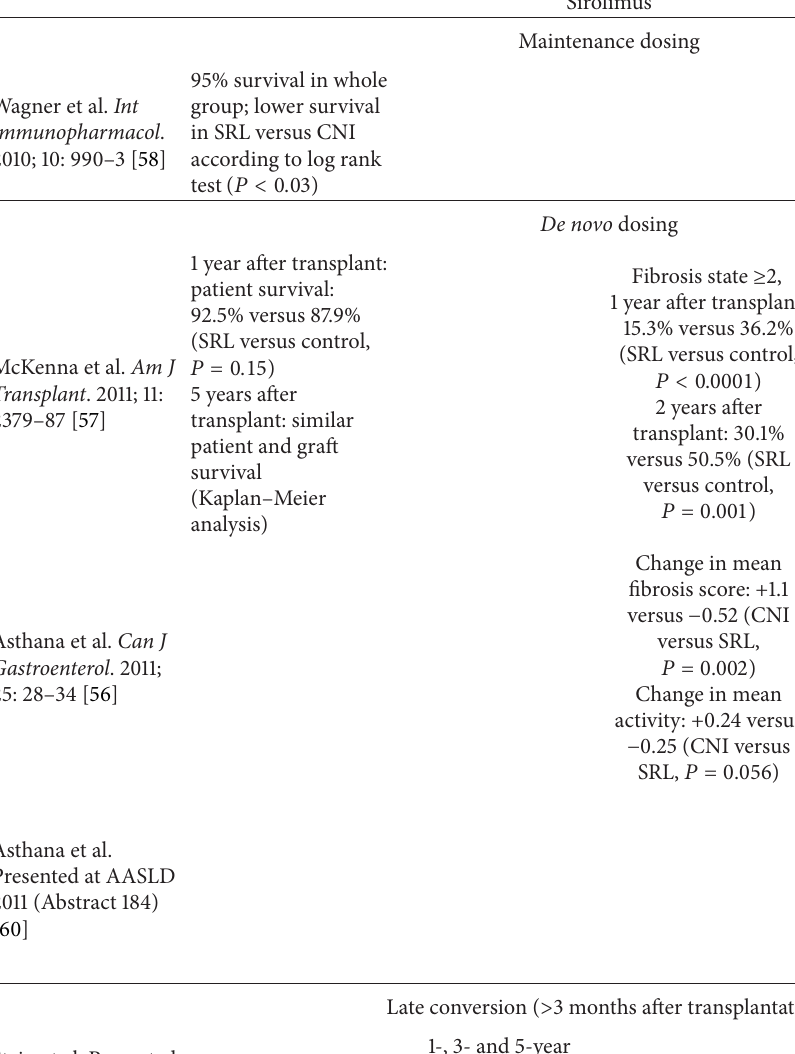
Table 7: Effects of mTOR inhibitors on hepatitis C virus and fibrosis progression in hepatitis C virus liver transplant recipients. Patient survival Graft survival Fibrosis HCV recurrence rate Other Sirolimus Maintenance